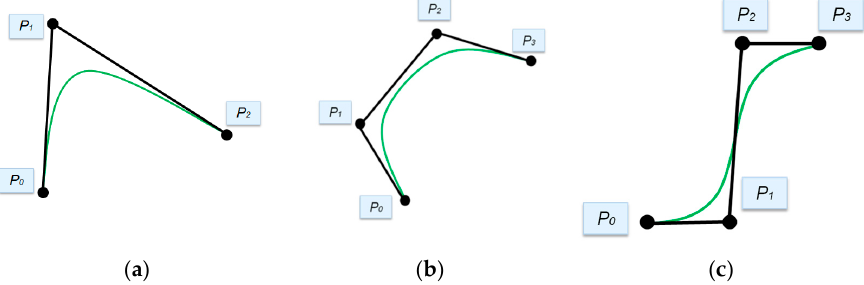
Figure 2. Bezier curve examples: ( a ) Second-order curve; ( b ) Third-order curve; ( с ) Third-order curve with another control point configuration.